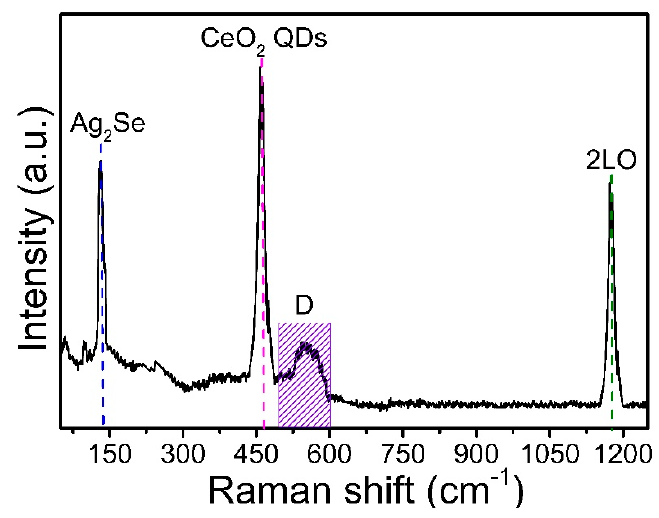
Figure 6. Room-temperature Raman scattering spectrum of 10% CeO 2 QDs/Ag 2 Se.